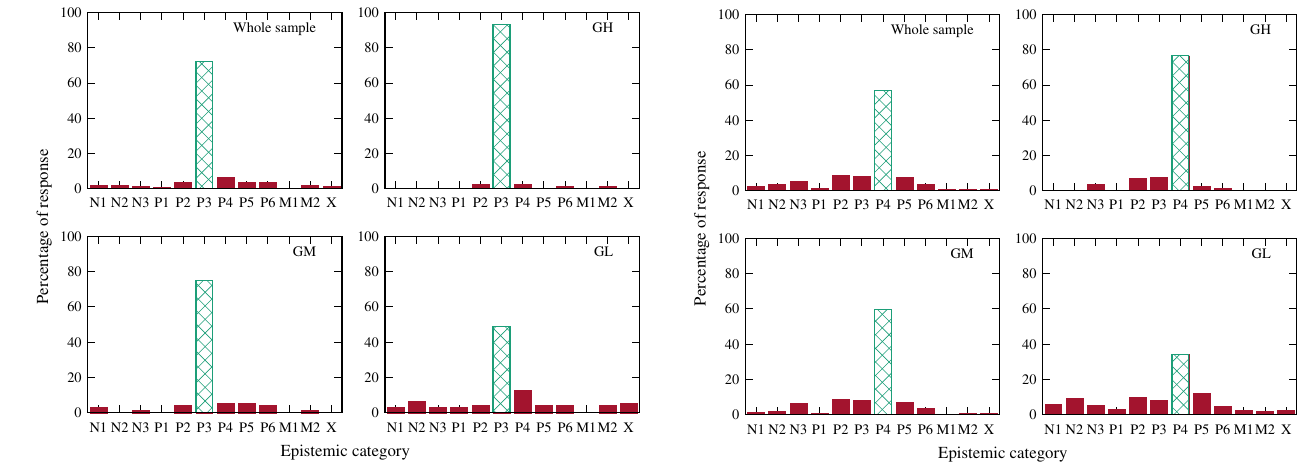
FIG. 8. Aggregate distribution of responses to the only propo- sition (S20) corresponding to epistemic category P3. Format of the figure is the same as in Fig. 4.